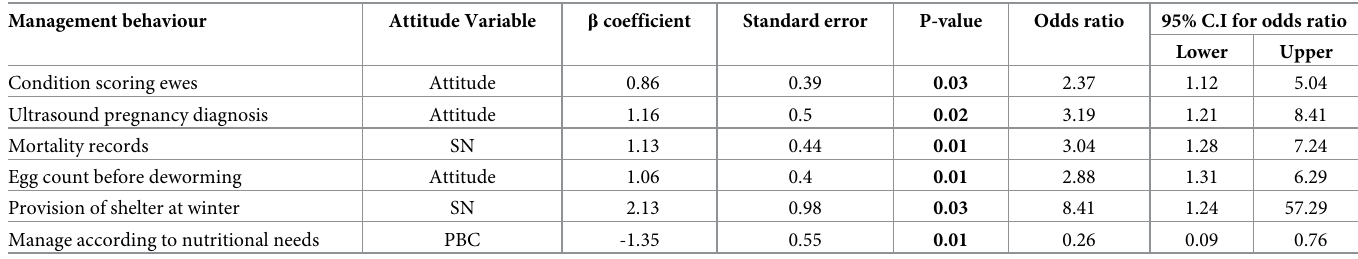
Table 7. Logistic regression analysis for farmer attitudes about management and farmer self-reported management behaviour (n = 32). Management